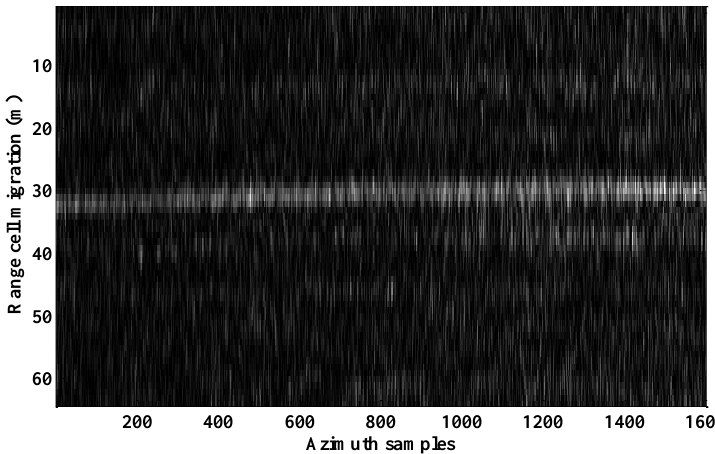
Figure 12. Range profiles without motion error compensation.